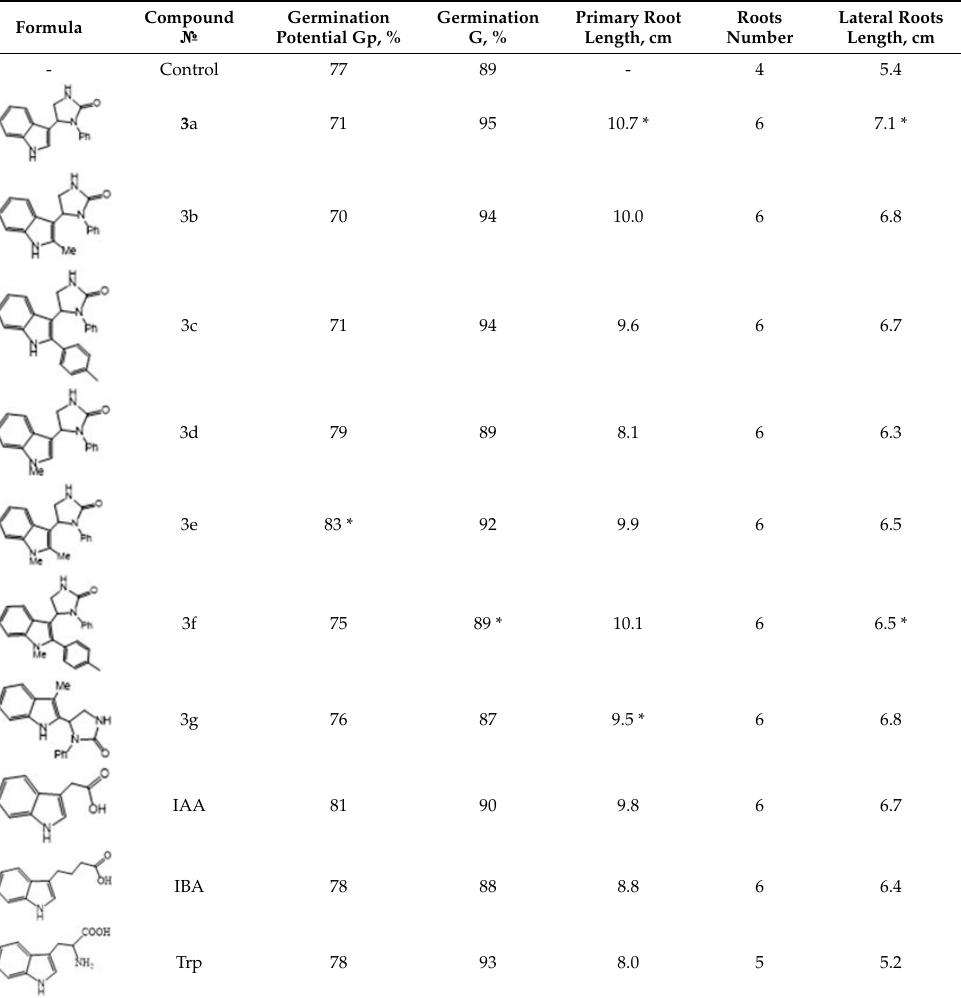
Table 1. Influence of hybrid compounds and indole-auxins on germination and roots